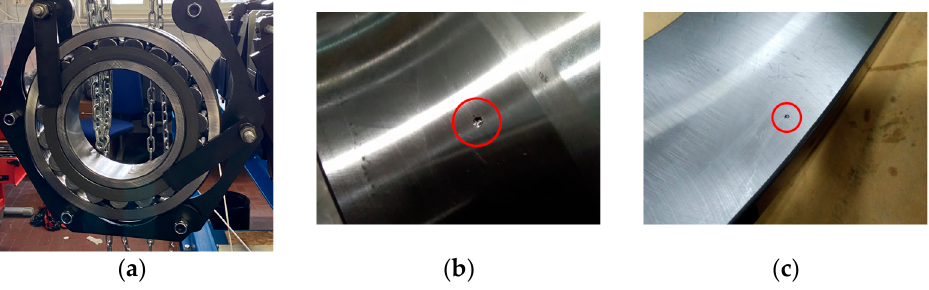
Figure 3. SKF 22240 CCK/W33 [29]: ( a ) normal state bearing during dismounting; ( b ) inner race damage with 2 mm diameter and 0.5 mm depth; and ( c ) outer race damage with 2 mm diameter and 0.5 mm depth. Table 1. Operating conditions. Case 1 Case